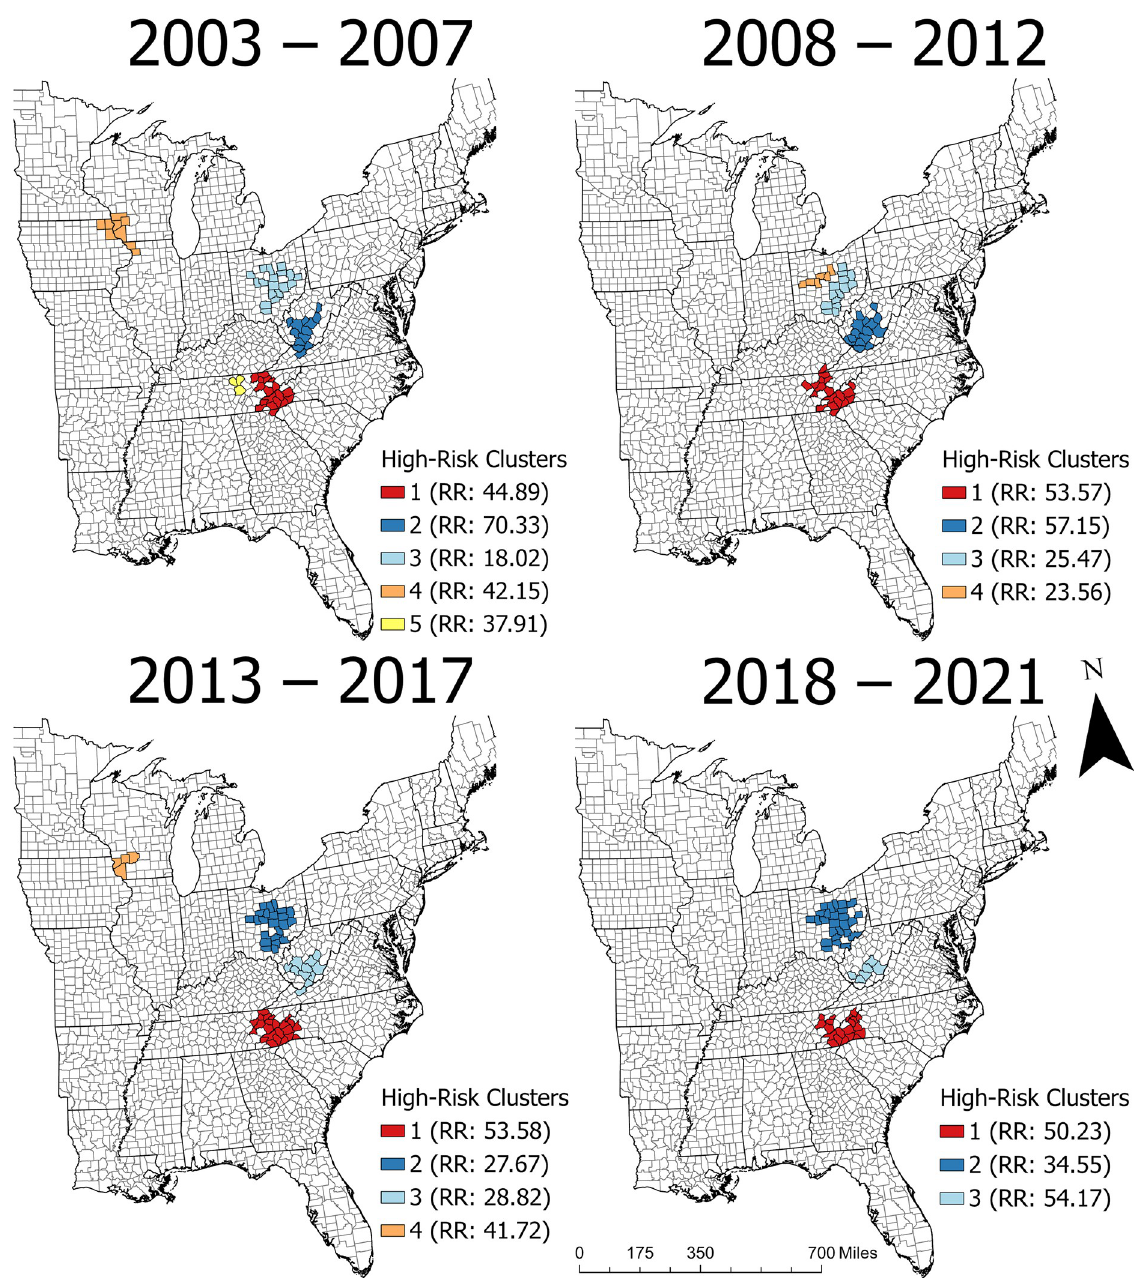
Fig 3. Statistically significant high-risk clusters with risk ratios (RR) of La Crosse virus neuroinvasive disease in the eastern United States from 2003–2021 (data obtained from ArboNET).